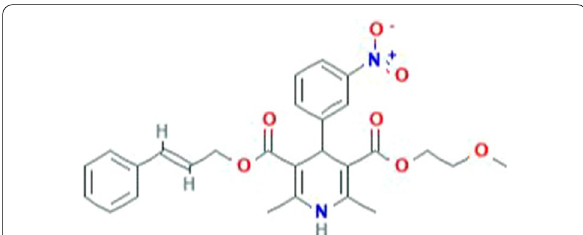
Fig. 1 The chemical structure of the drug cilnidipine